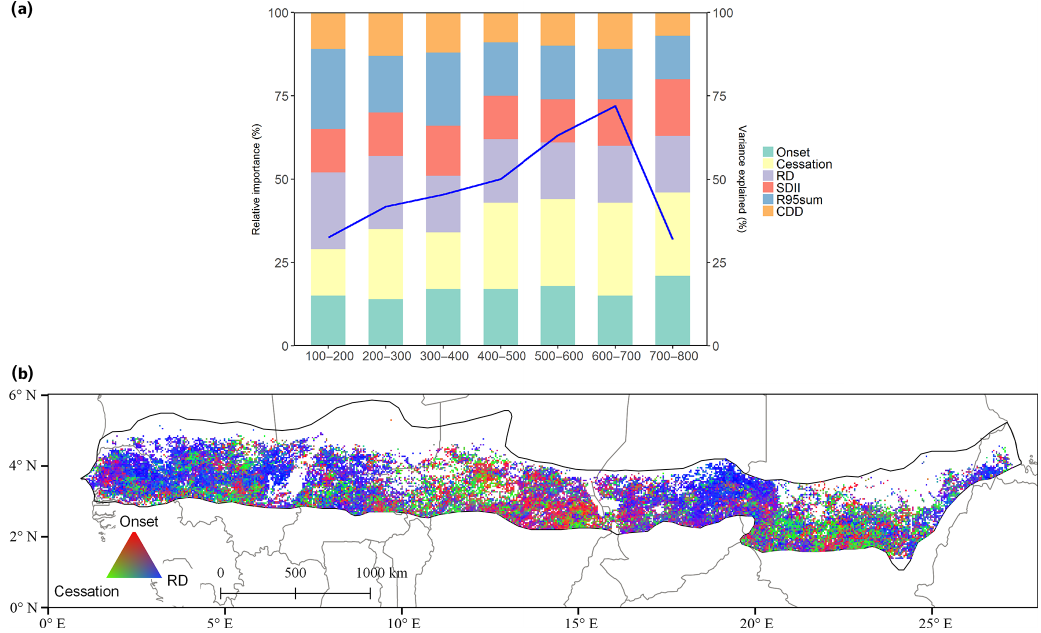
Figure 8. (a) Generalized relationships between growing season ANPP and onset, cessation, RD, SDII, R95sum, and CDD as a function of seasonal rainfall amount (100mm intervals) based on 15-year average values (relative importance in %). The blue line shows the overall variance of growing season ANPP explained by the rainfall metrics per 100mm seasonal rainfall amount based on the random forest method. (b) Spatial distribution of the relative importance of onset and cessation of wet season and rainy days for growing season ANPP for 2001– 2015 based on a multiple-regression analysis. Pixels within the study area are masked (white colour) in accordance with the description in the methods